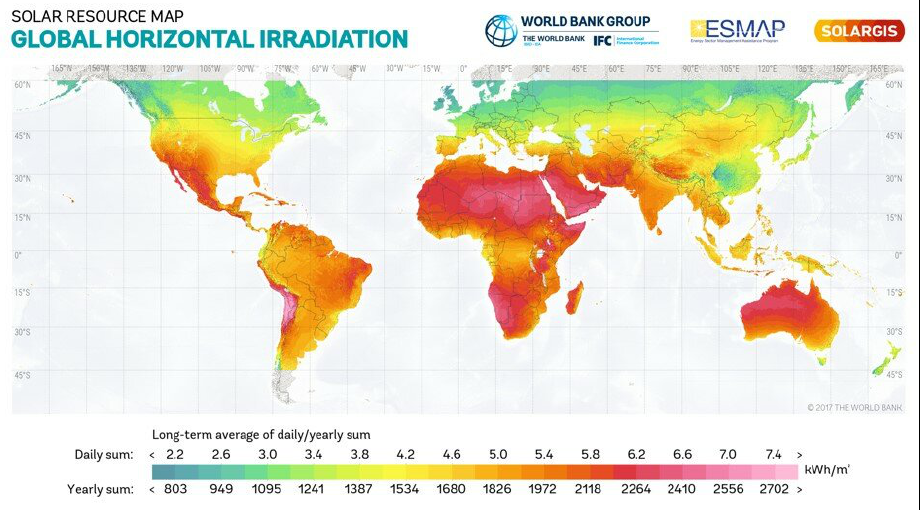
Figure 1. The worldwide horizontal solar radiation